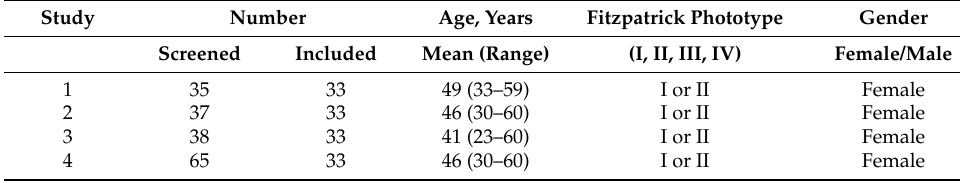
Table 2. Population